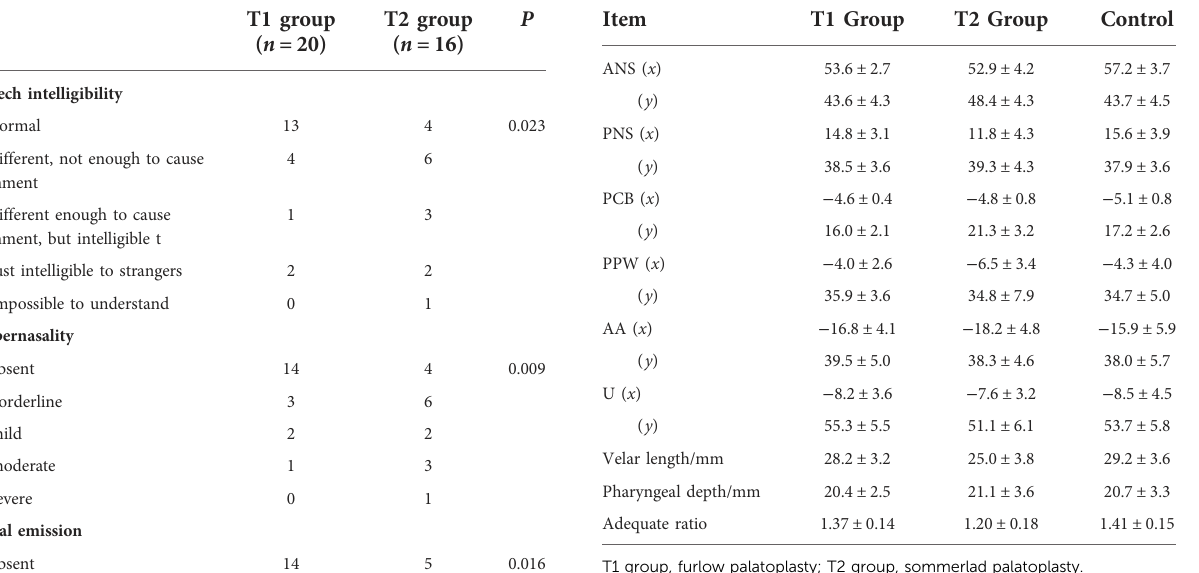
TABLE 3 Comparison of cephalometric landmarks among three groups.